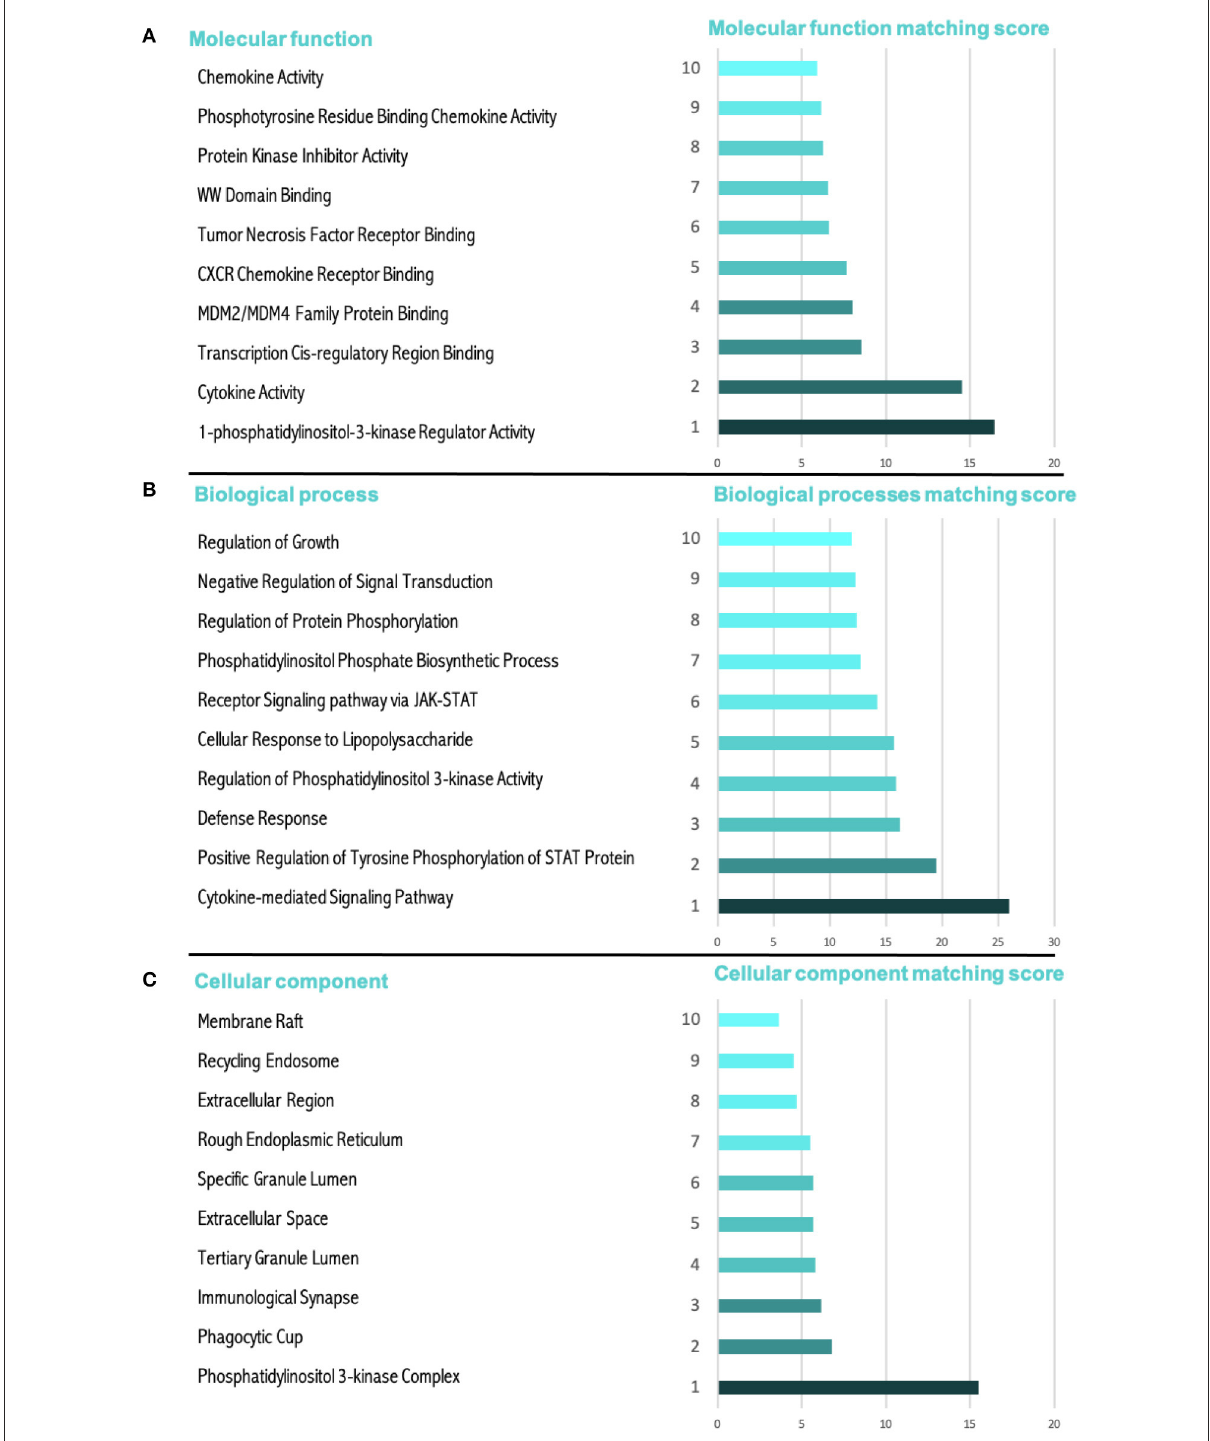
FIGURE5 The gene ontology (GO) score for miR-203’s target genes and miR-203 itself. (A) A cellular component and the score that matches it. (B) A molecular function and the score that matches it. (C) A biological process and the score that matches